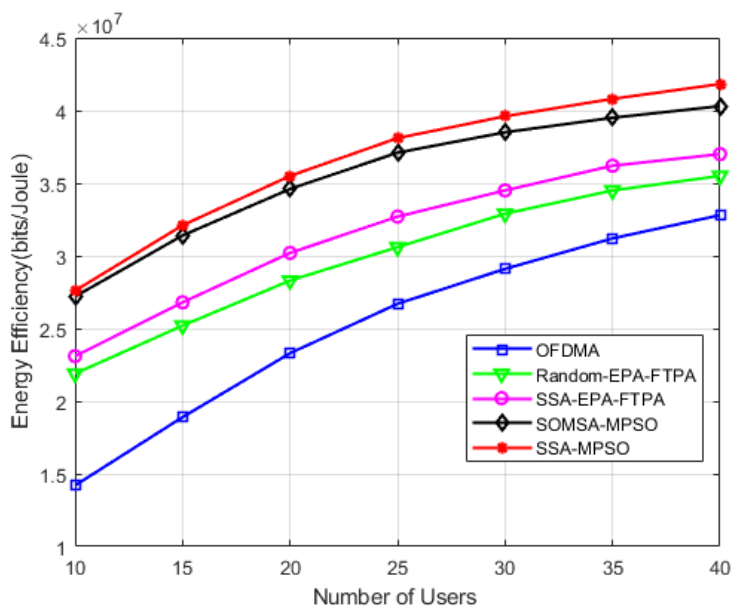
Figure 4. Energy efficiency versus the number of